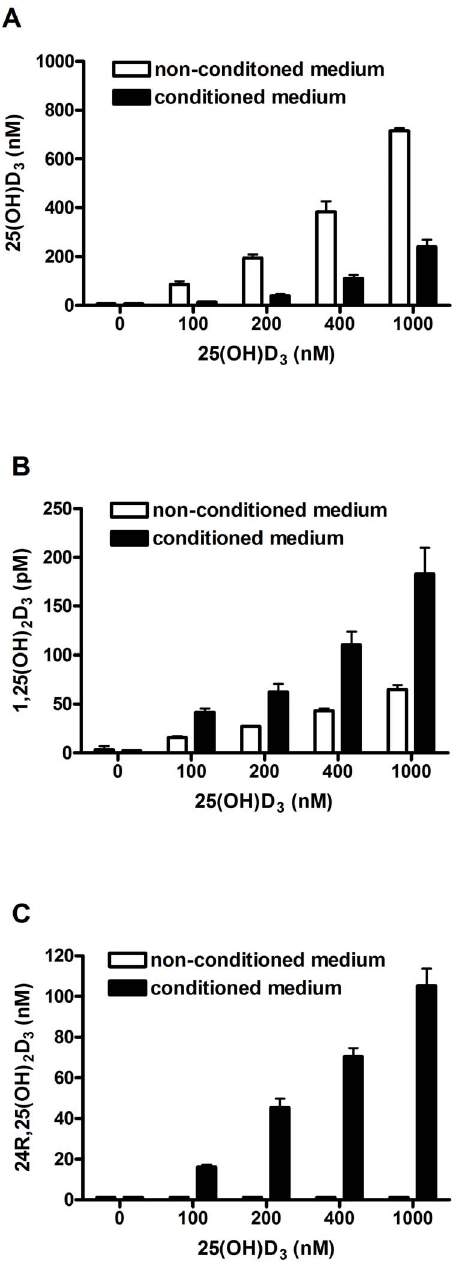
Figure 5. Synthesis of 1,25(OH) 2 D 3 and 24R,25(OH) 2 D 3 by primary human osteoblasts. Osteoblasts were cultured in the presence of 0, 100, 200, 400 and 1.000 nM 25(OH)D 3 for 24 hours and 25(OH)D 3 ( A ) 1,25(OH) 2 D 3 ( B ) and 24R,25(OH) 2 D 3 ( C ) levels were measured in non-conditioned and conditioned culture medium. Results are expressed as mean 6 SEM using cells from 3 different donors.